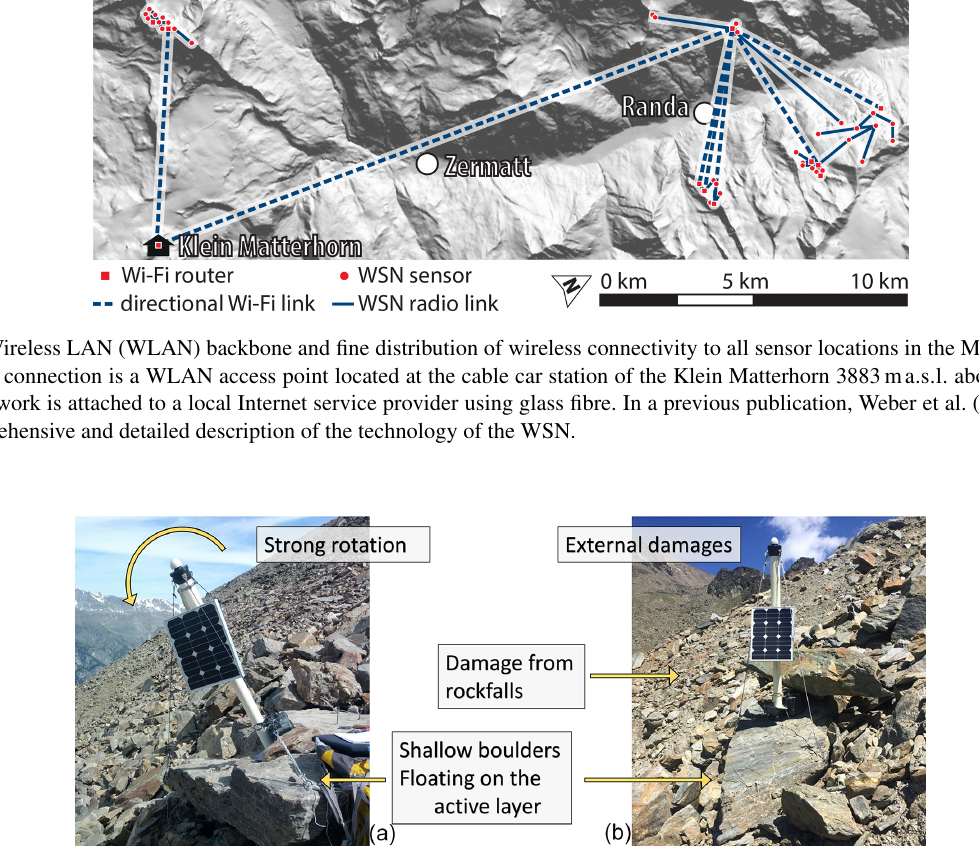
Earth Syst. Sci. Data, 14, 5061–5091,